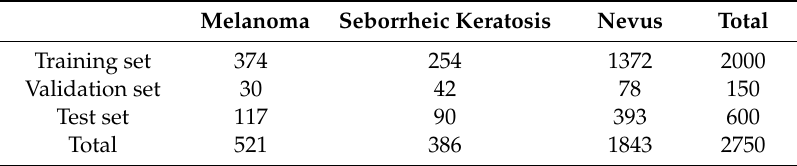
Table 2. The number of various lesion types in the training set, validation set and test